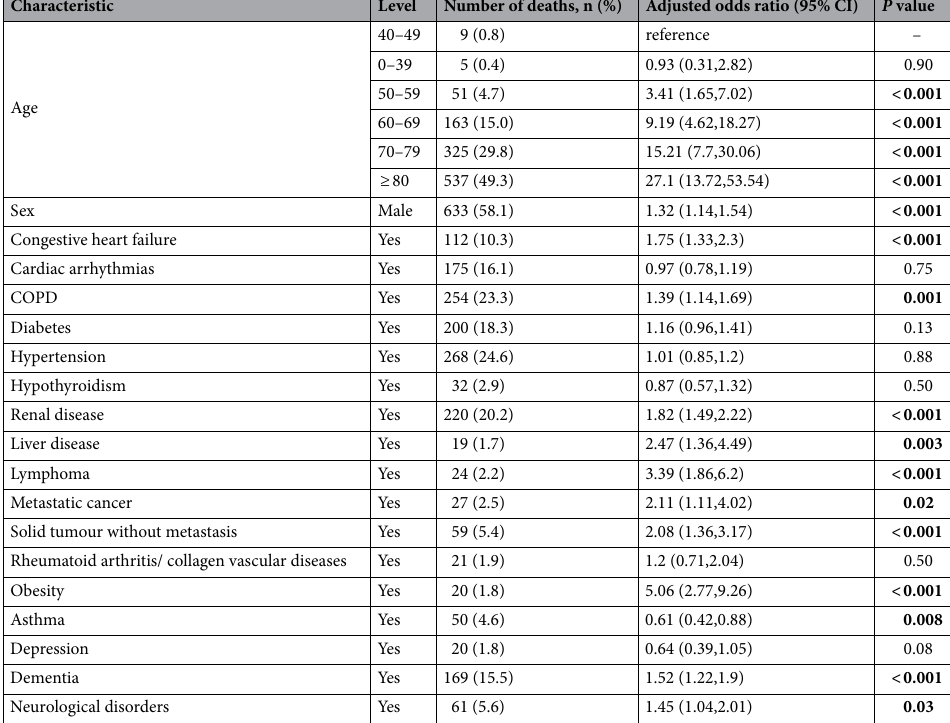
Table 6. Sensitivity analysis for the association between pre-existing health conditions and in-hospital mortality in patients with COVID-19. COVID-19 deaths were defined as COVID-19 related admissions with ICD-10 diagnosis code U07.1 or U07.2 as the primary code for clinical diagnosis. Statistically significant P < 0.05 values are in bold. Observations, n = 4960 including 1090 COVID-19 deaths. CI Confidence Interval; COPD Chronic obstructive pulmonary